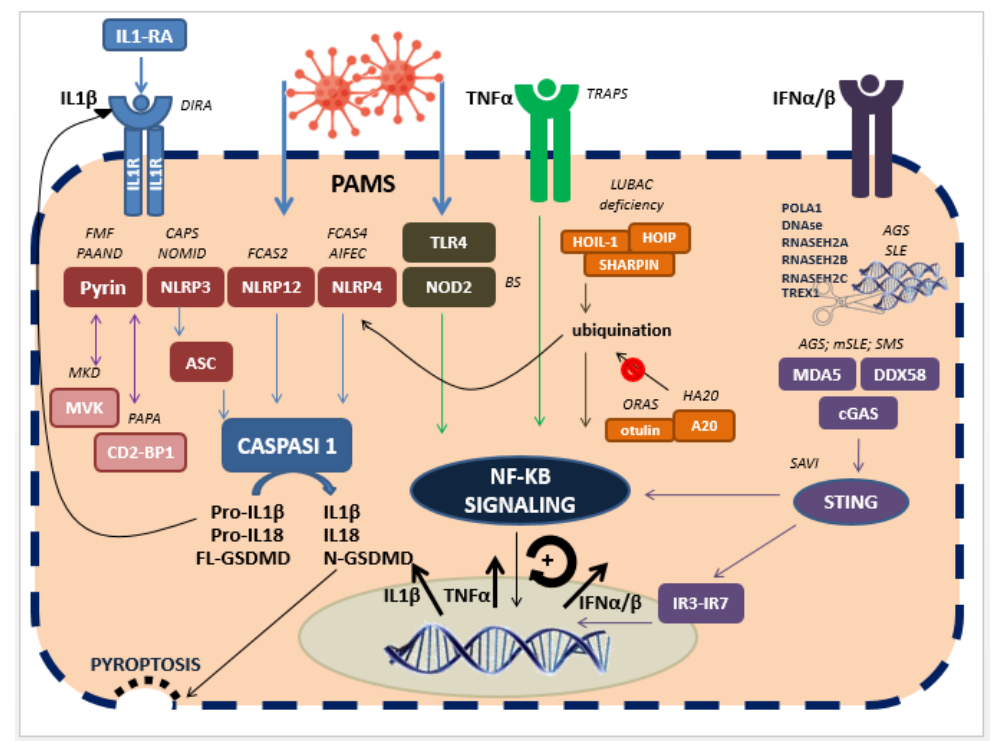
Figure 1. Inflammatory signalling pathways in AIDs. The first step of inflammatory response is the recognition of pathogens’ conserved structures (PAMP) by PPR of intracellular sensors (including NLR domains, ALR and pyrine), with the formation of a multimeric proteic complex, called inflammasome. The inflammasome receptors interact with the adapter protein ASC, leading to the activation of Caspase 1, which converts pro-IL-1 β and pro-IL-18 to their bioactive forms. Caspase 1 also cleavages the Gasdermin-D (GSDMD), whose N-terminal domain (GSDMD-N) forms cytotoxic pores in the lipidic cellular membrane, causing pyroptosis. Also, PAMPs are sensed by TLRs (mainly TLR-4) or NOD2 receptors and activate NF- κ B pathway, enhancing NLRP-3 transcription. The intra-cytoplasmic accumulation of viral or endogenous nucleic acids is sensed by others proteins, like cGAS, MDA5 and DDX58, which activate STING and therefore IR3-IR7 factors. These latter translocate to the nucleus, stimulating the transcription of type I IFN genes. STING also directly activates NFkB signalling. Most of the described signalling pathways activate NF- κ B signalling, thus stimulating the transcription of NF- κ B-dependent genes (NLRP3, pro-IL- β , pro-IL-18, and IL-6) and promoting a positive feedback effect. Alterations at different levels of this complex mechanism are associated with the development different AIDs. Abbreviations : PAMP (pathogen associated molecular patterns); PRR (pattern recognition receptors); NLR (Nucleotide-binding oligomerization domain (NOD)-like receptors); ALR (Absence in melanoma 2 (AIM2)-like receptors); NLRP-3 (NLR family pyrin domain containing 3); NF- κ B (NF-kappaB); IFN (interferon); IRF (IFN regulatory factor); CGAS (cyclic GMP-AMP synthase); MDA5 (melanoma differentiation-associated protein 5; DDX58 (DExD/H box RNA helicase); STING (Stimulator of interferon genes).